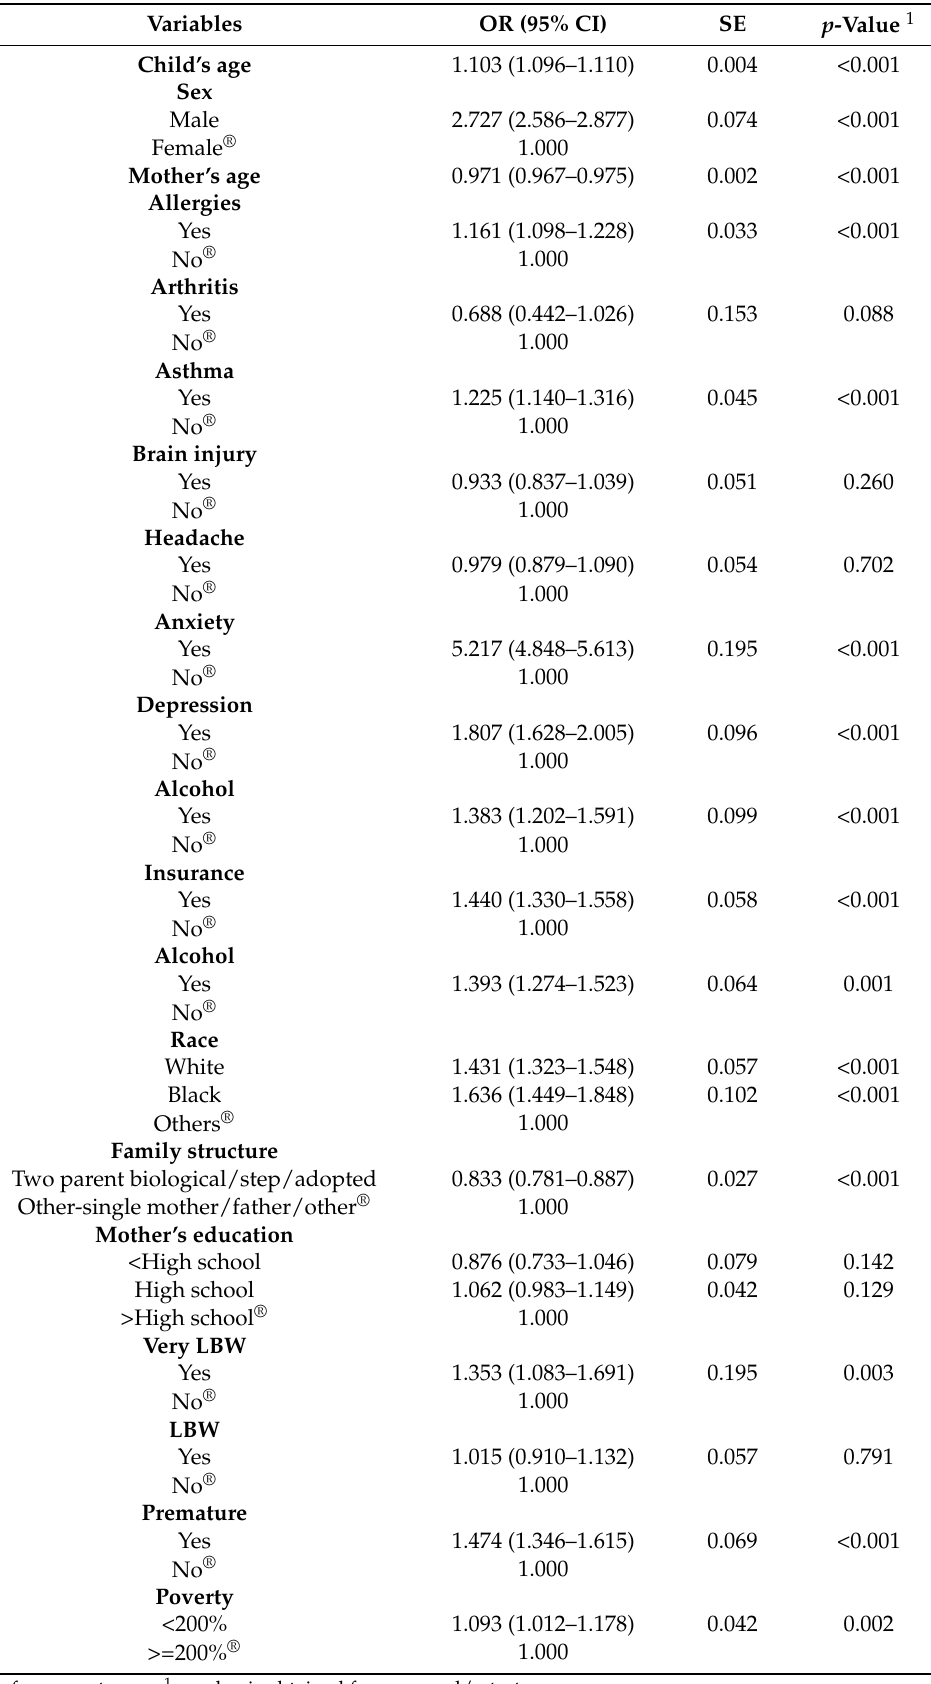
Table 4. Identifying the risk factors for ADHD using